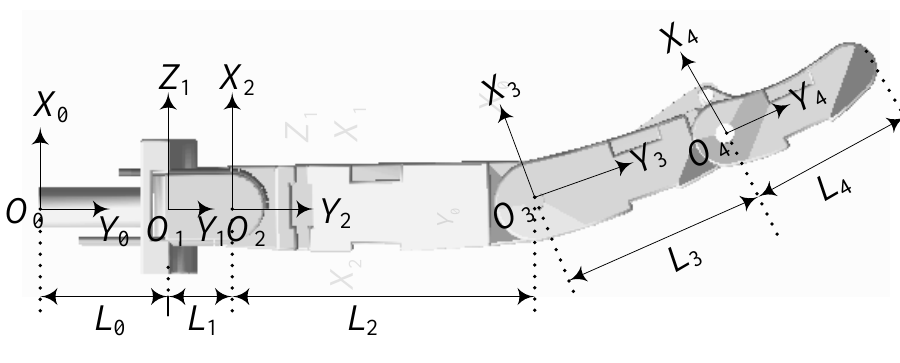
Figure 7. The coordinate systems buit in the finger model.